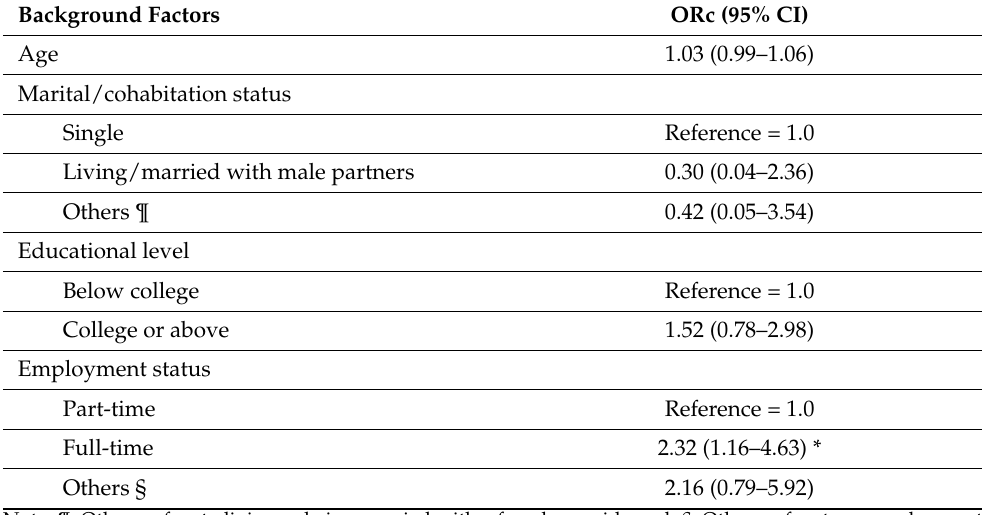
Table 3. Associations between the background factors and COVID-19 vaccination.